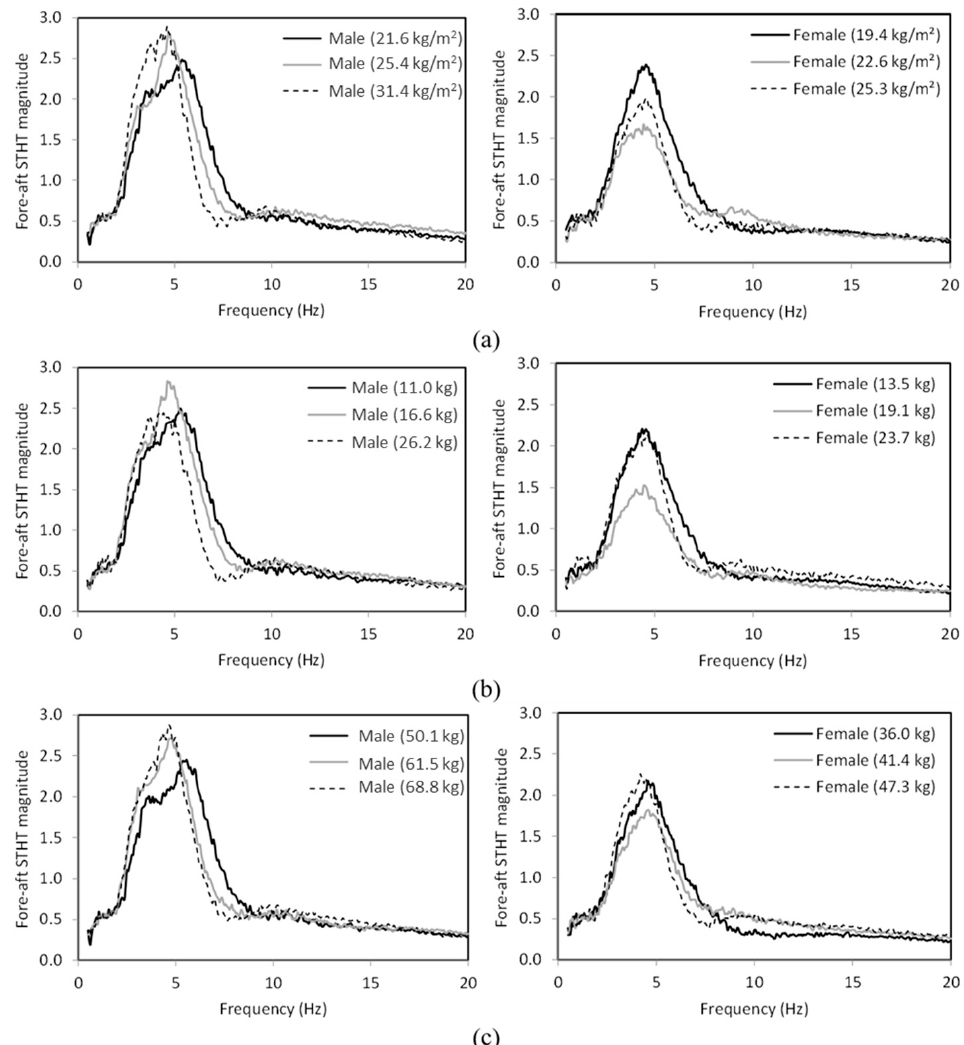
Figure 10. Effects of mass-related parameters on mean fore-aft STHT magnitude responses of male and female subjects: ( a ) BMI; ( b ) body fat mass; and ( c ) lean body mass (NB support, 0.50 m/s 2 excitation).